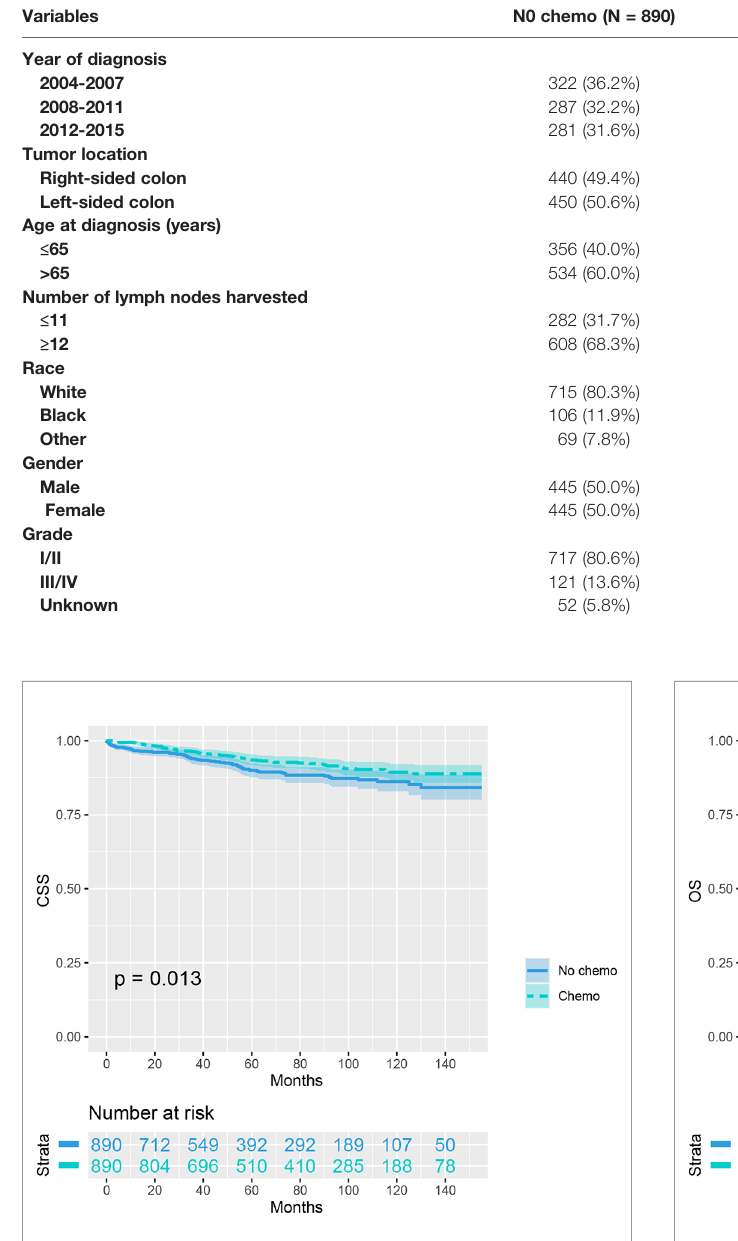
FIGURE 3 | Kaplan-Meier plot, revealing the cancer-speci fi c survival differences based on the receipt of adjuvant chemotherapy in T1N+ colon cancer patients after propensity score matching.